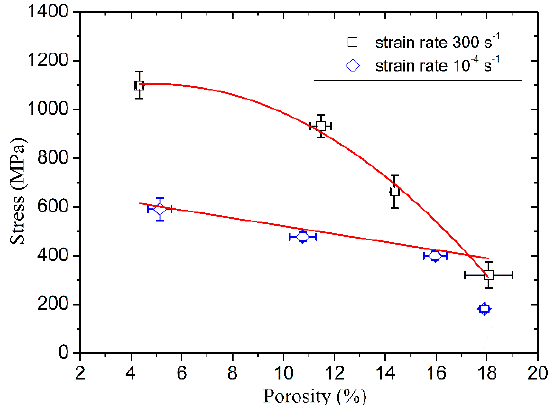
Figure 10. The compressive strength vs. porosity at the strain rate of 300 s − 1 and 10 − 4 s − 1 . According to the measured stress–strain curves of porous poled ceramics with different porosities in Figure 9, we also examined the porosity dependence of the critical stress for the initiation of DS and PT at the strain rate of 10 − 4 s − 1 and 300 s − 1 , respectively. First, the critical stress of σ D and σ P are normalized as a function of porosity by σ D 0 and σ P 0 , where σ D 0 and σ P 0 are the values of σ D and σ P for the materials at a porosity of 0%. These values were determined to be σ D 0 ≈ 108 MPa, σ P 0 ≈ 199 MPa at the strain rate of 10 s and σ D 0 ≈ 156 MPa, σ P 0 ≈ 270 MPa at the 300 s strain rate, which were